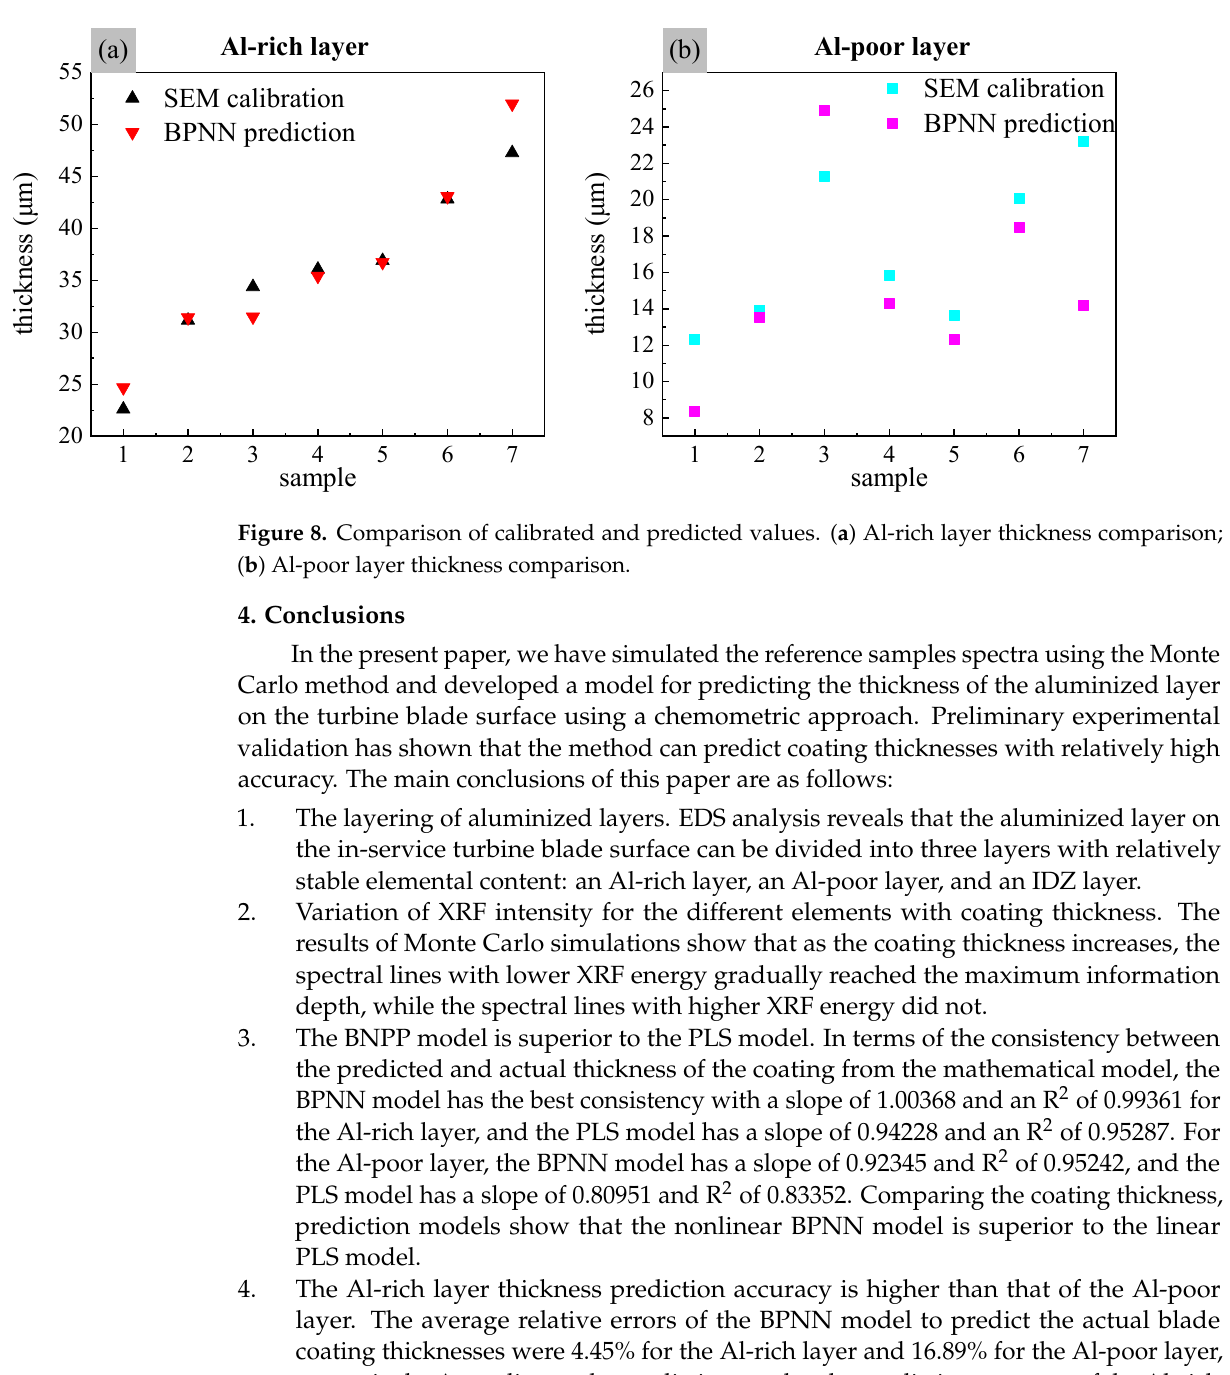
Figure 7. Spectral comparison of coating and substrate material.